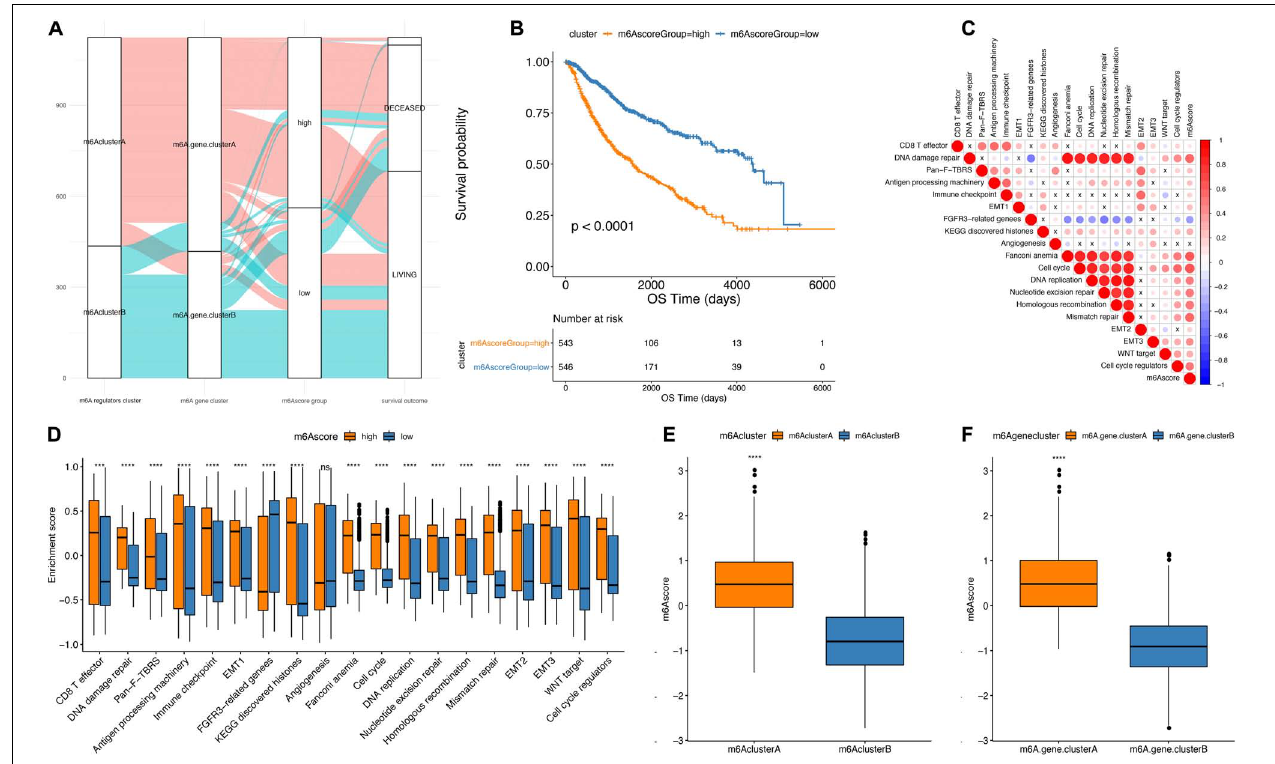
FIGURE 6 | Establishment of m6Ascore. (A) Alluvial plot showing the changes of m6A cluster, gene cluster and m6Ascore. (B) Kaplan-Meier curve shows that m6Ascore high and low grouping has a significant relationship with overall survival rate. (C) Using Pearson analysis, the correlation between m6Ascore and known gene features in low-grade gliomas. Negative correlation is marked in blue, and it is positively correlated with red. X in the figure indicates that the correlation is not significant, and the larger the circle, the more significant. (D) The distribution of the enrichment scores of known gene features in the m6Ascore high and low group samples in the TCGA+CGGA data set (*** p < 0.01, **** p < 0.001). (E) The distribution of m6Ascore in m6A regulators cluster (**** p < 0.001). (F) Distribution of m6Ascore in m6Agenecluster (**** p <